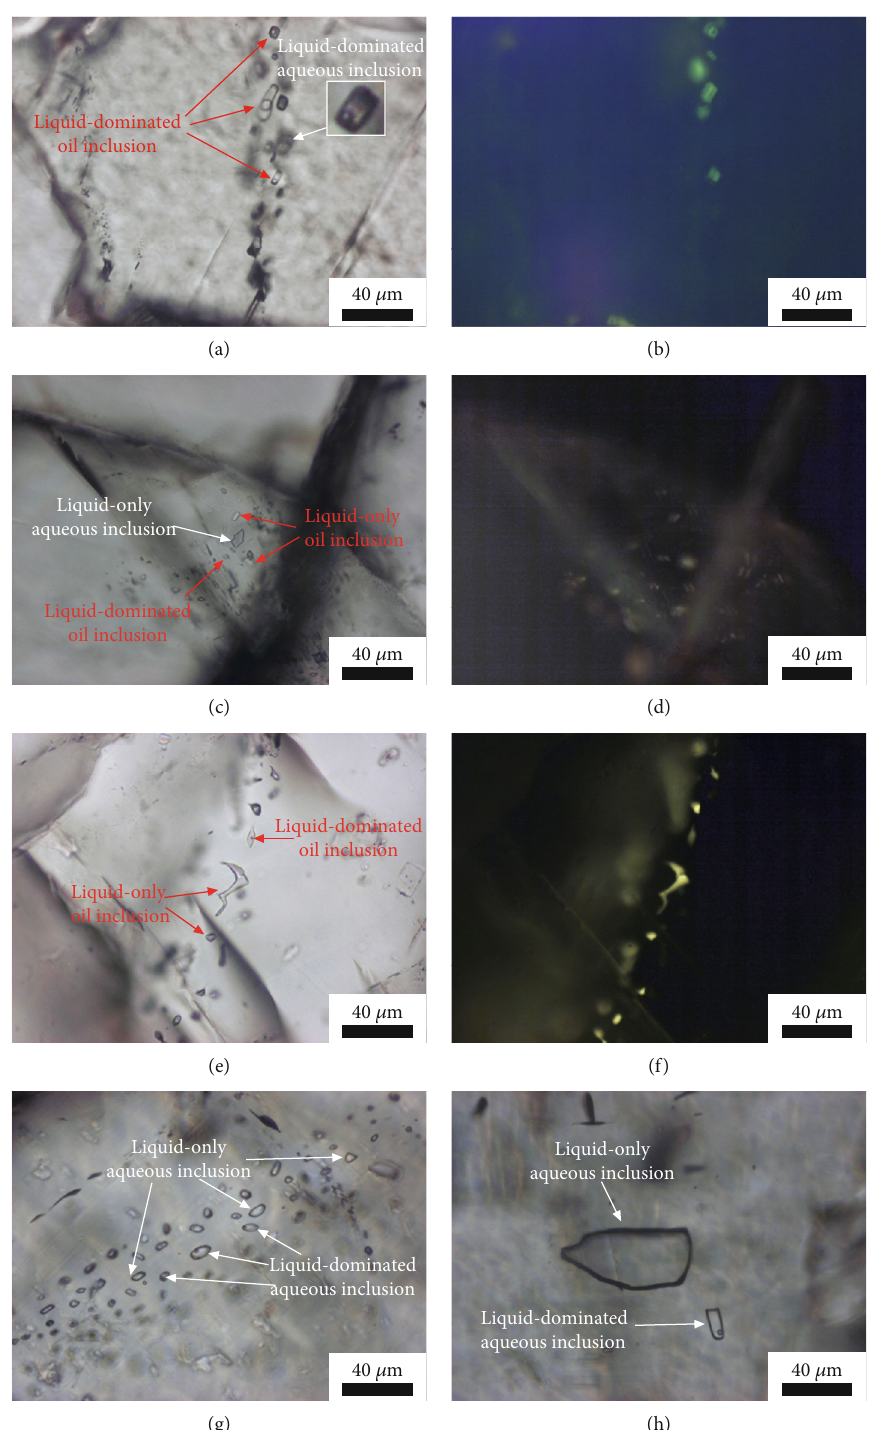
Figure 4: The petrographic characteristics of fl uid inclusions. (a, b) Liquid-dominated aqueous inclusions and liquid-dominated biphase oil inclusions coexisting in trails CT1; plane polarized light and fl uorescent light (SHB1-3; 7269.1m; O yj ). (c, d) Liquid-only aqueous inclusions, 2 liquid-only oil inclusions, and liquid-dominated biphase oil inclusions coexisting in trails CT5; plane polarized light and fl uorescent light (SHB5-8; 7678.8m; O yj ). (e, f) Liquid-only oil inclusions and liquid-dominated biphase oil inclusions coexisting in trails CT5; plane 2 polarized light and fl uorescent light (SHB5-8; 7679.3 m; O yj). (g) Liquid-only aqueous inclusions and liquid-dominated biphase aqueous 2 y ). (h) Liquid-only aqueous inclusions and liquid- inclusions coexisting in trails CTp1-f; plane polarized light (SHBp1; 8450.1m; O 1 − 2 dominated biphase aqueous inclusions coexisting in trails CTp1-v; plane polarized light (SHBp1; 8450.1m; O y 1 − 2